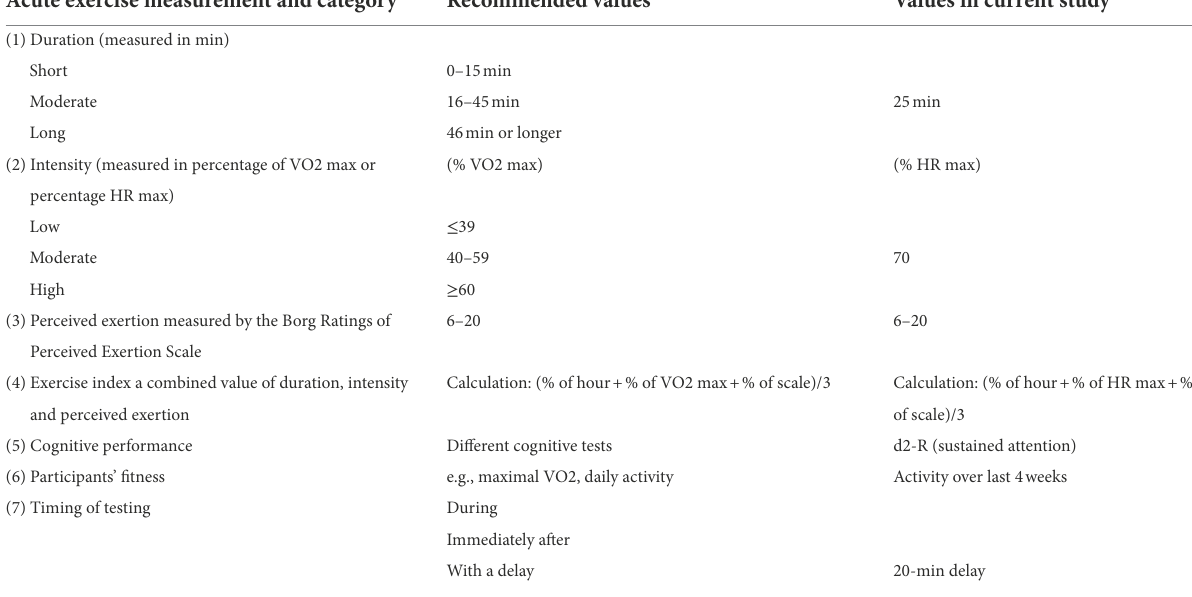
TABLE 1 Recommended acute exercise study standards and values based on Basso and Suzuki (2017, Points 1–4: Duration, Intensity, Perceived exertion, and Exercise index) and Chang et al. (2012, Points 5–7: Cognitive performance, Participants’ fitness, and Timing of testing) and values used in the current